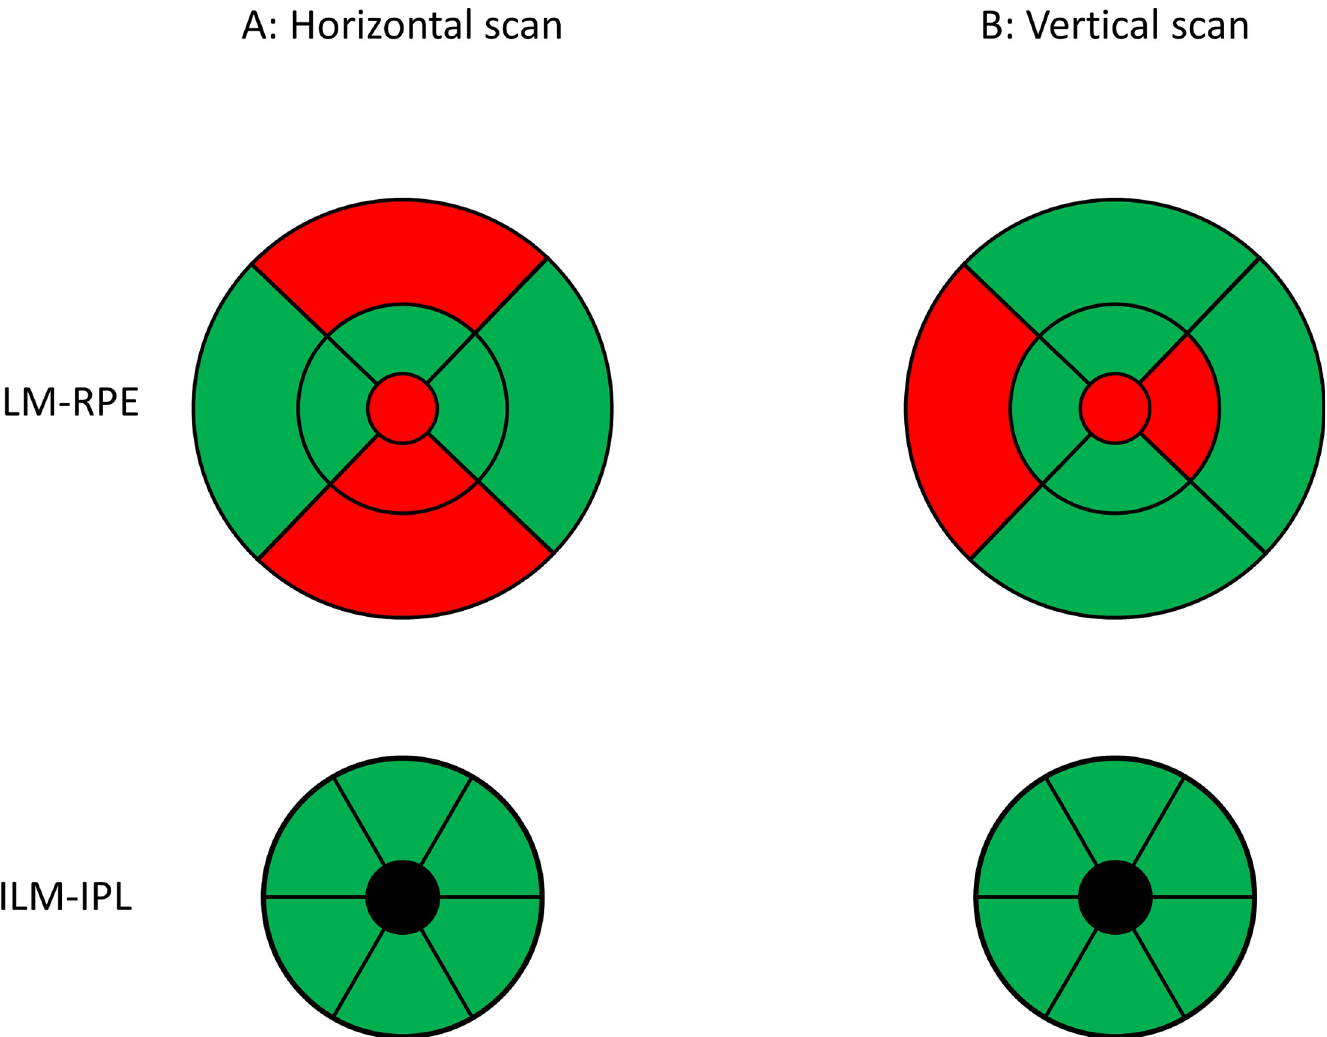
Fig 5. Colour coded map of the intra-device repeatability for the macula scans in different sectors. Green: repeatability limit values within the instrument’s axial resolution, Red: repeatability limit values above the instrument’s axial resolution. ILM-RPE: inner limiting membrane to retinal pigment epithelium thickness ILM-IPL: inner limiting membrane to inner plexiform layer